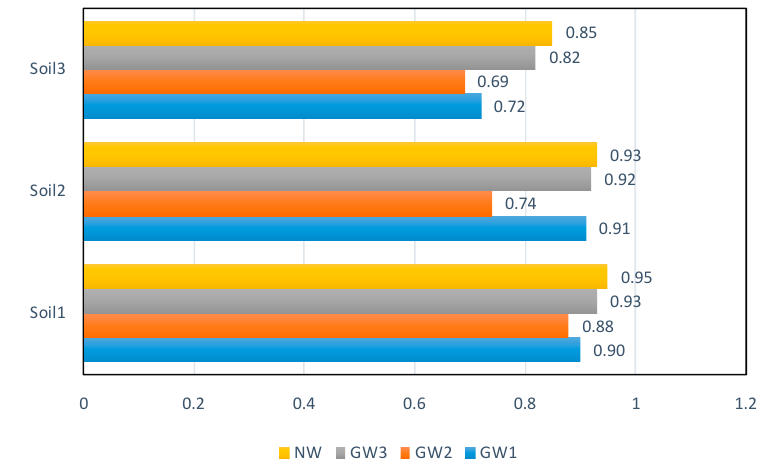
Figure 9. Interface efficiency of Figure 9 . Interface efficiency of soils~geosynthetics . Table 3. Interface friction parameters including friction angles, friction coefficient, and interface efficiency from modified direct shear tests .